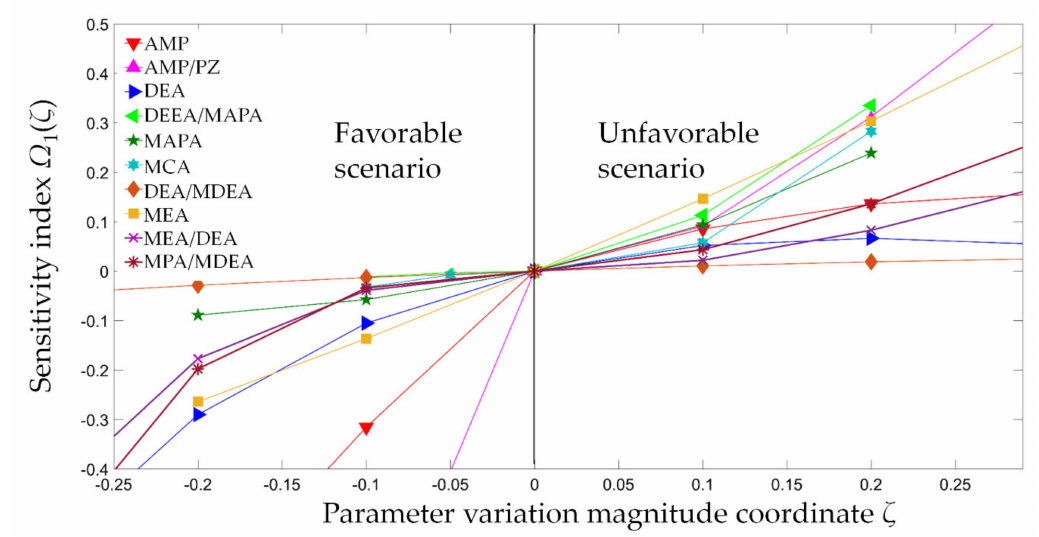
Figure 3. Sensitivity index Ω 1 ( ζ ) versus the parametric variation magnitude coordinate ζ .